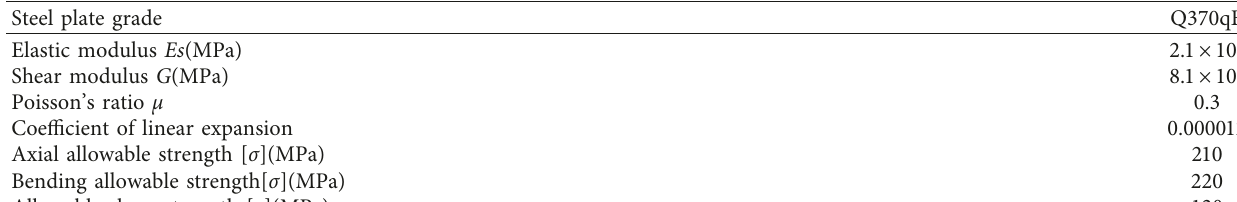
Table 8: Mechanical properties of steel plate.